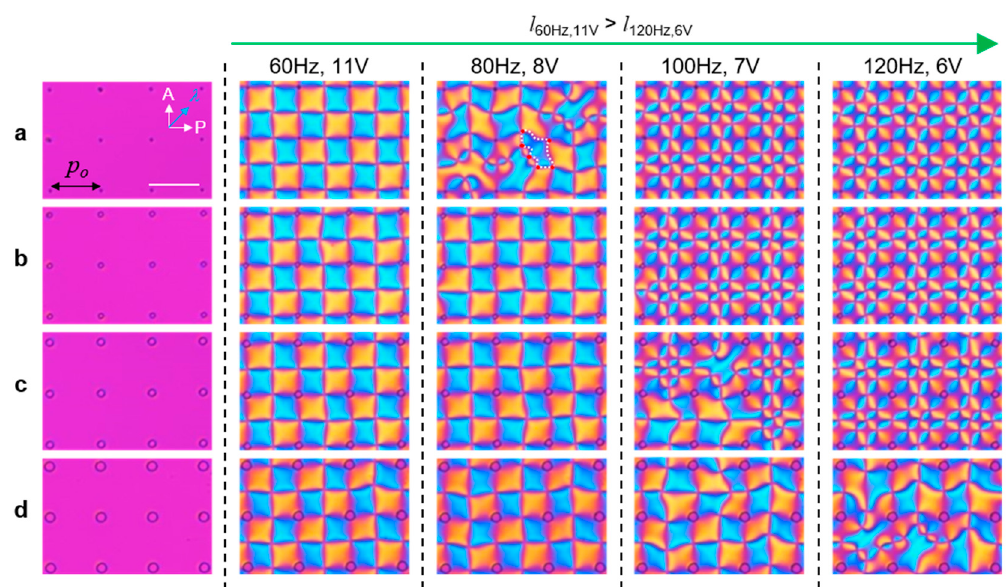
Figure 2. Defect array formation observed by polarizing optical microscopy with a full-wave plate inserted at 45 degrees between the crossed polarizers (used to distinguish +1 from − 1 defects), when varying the pillar diameter a : ( a ) a = 2 μ m; ( b ) a = 4 μ m; ( c ) a = 6 μ m; and ( d ) a = 8 μ m. Pillar height is h = 3 μ m, cell thickness is d = 5.4 μ m, and p o = 50 μ m. P, polarizer; A, analyzer; λ , full-wave plate. The red dots and white-dotted line indicate a broken-square domain surrounded by six defects. Scale bar is 50 µ